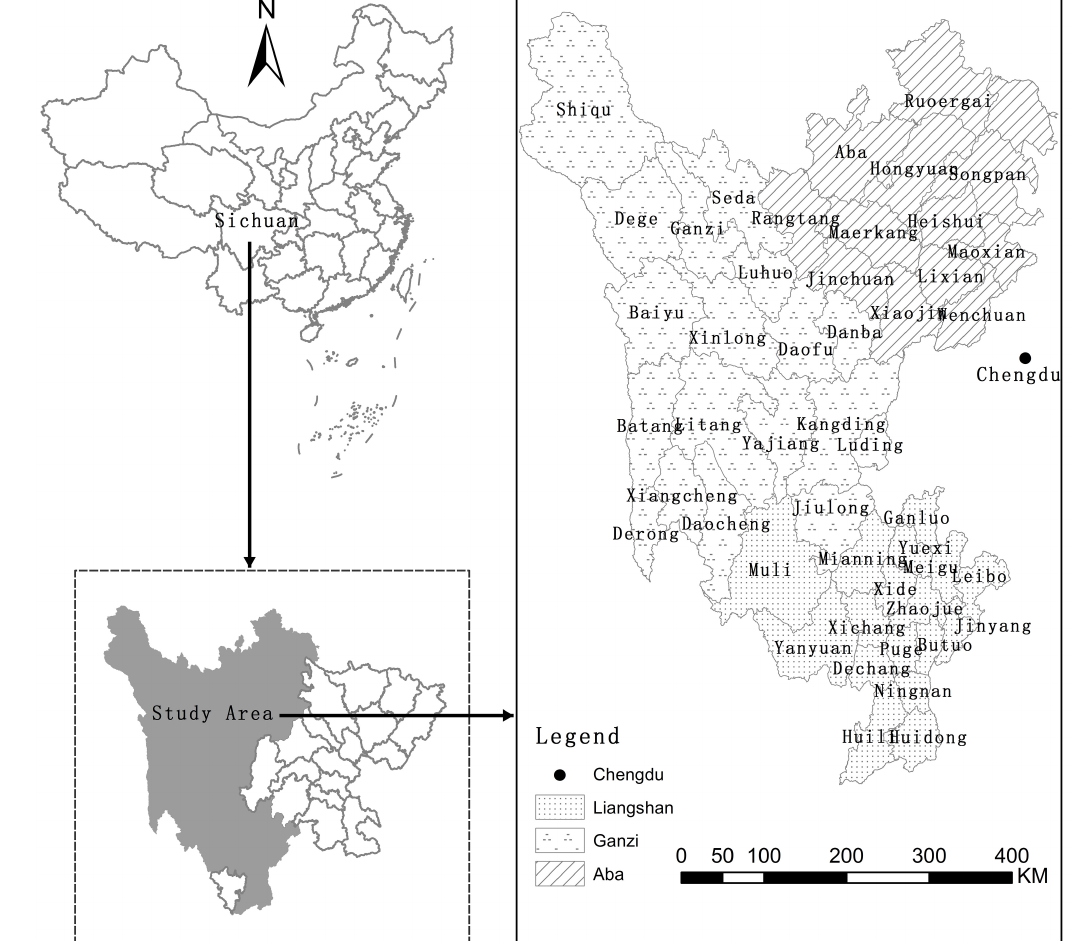
Figure 3. Location of study